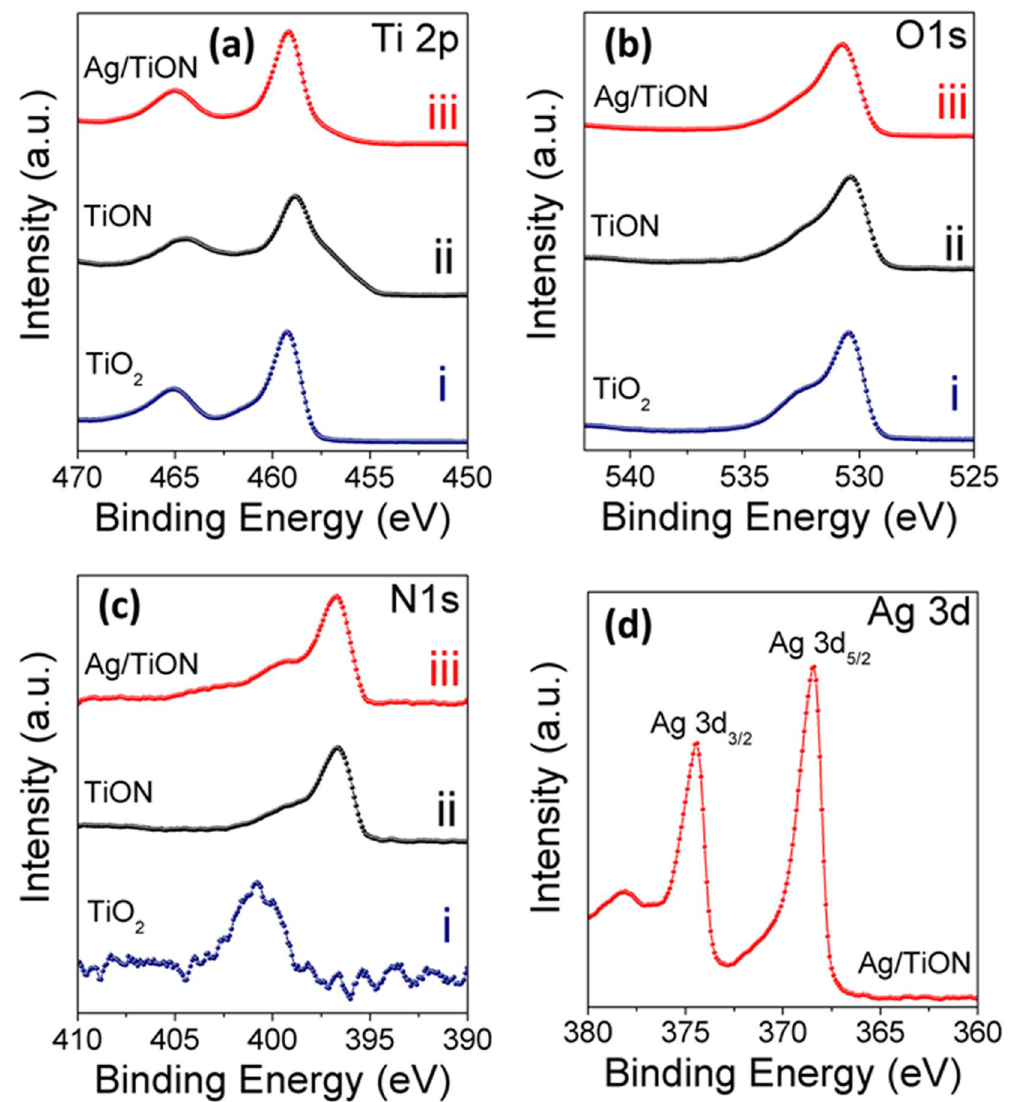
Figure 3. XPS spectra of the (i) air-annealed, (ii) ammonia-annealed, and (iii) Ag-decorated ammonia- annealed nanotube samples.